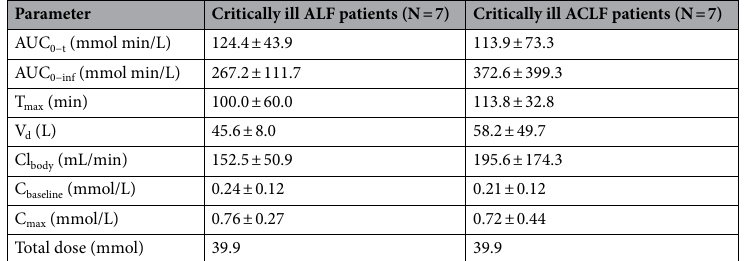
Table 3. Citrate PK. AUC area under the plasma concentration–time curve, T max time to maximum concentration, V d volume of distribution, Cl body citrate clearance by body, C baseline baseline citrate concentration,